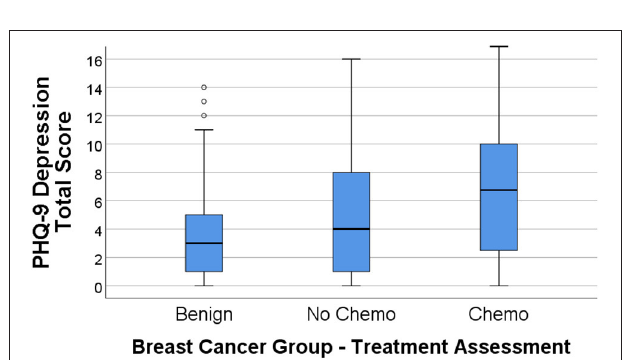
FIGURE 2 | PHQ-9 depression total score box plots for the benign (breast lump autopsy), no-chemo (treatment for breast cancer), and chemo (treatment for breast cancer) groups. Higher scores mean greater total depression, with the median group value-line bisecting the box, top and bottom of the box representing 3rd and 1st percentile, and upper-value range of scores capped above the box (along with outliers for the benign group).